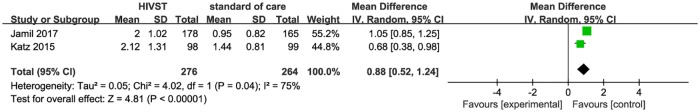
Meta-analysis on mean number of HIV tests for MSM in a 6-month period.